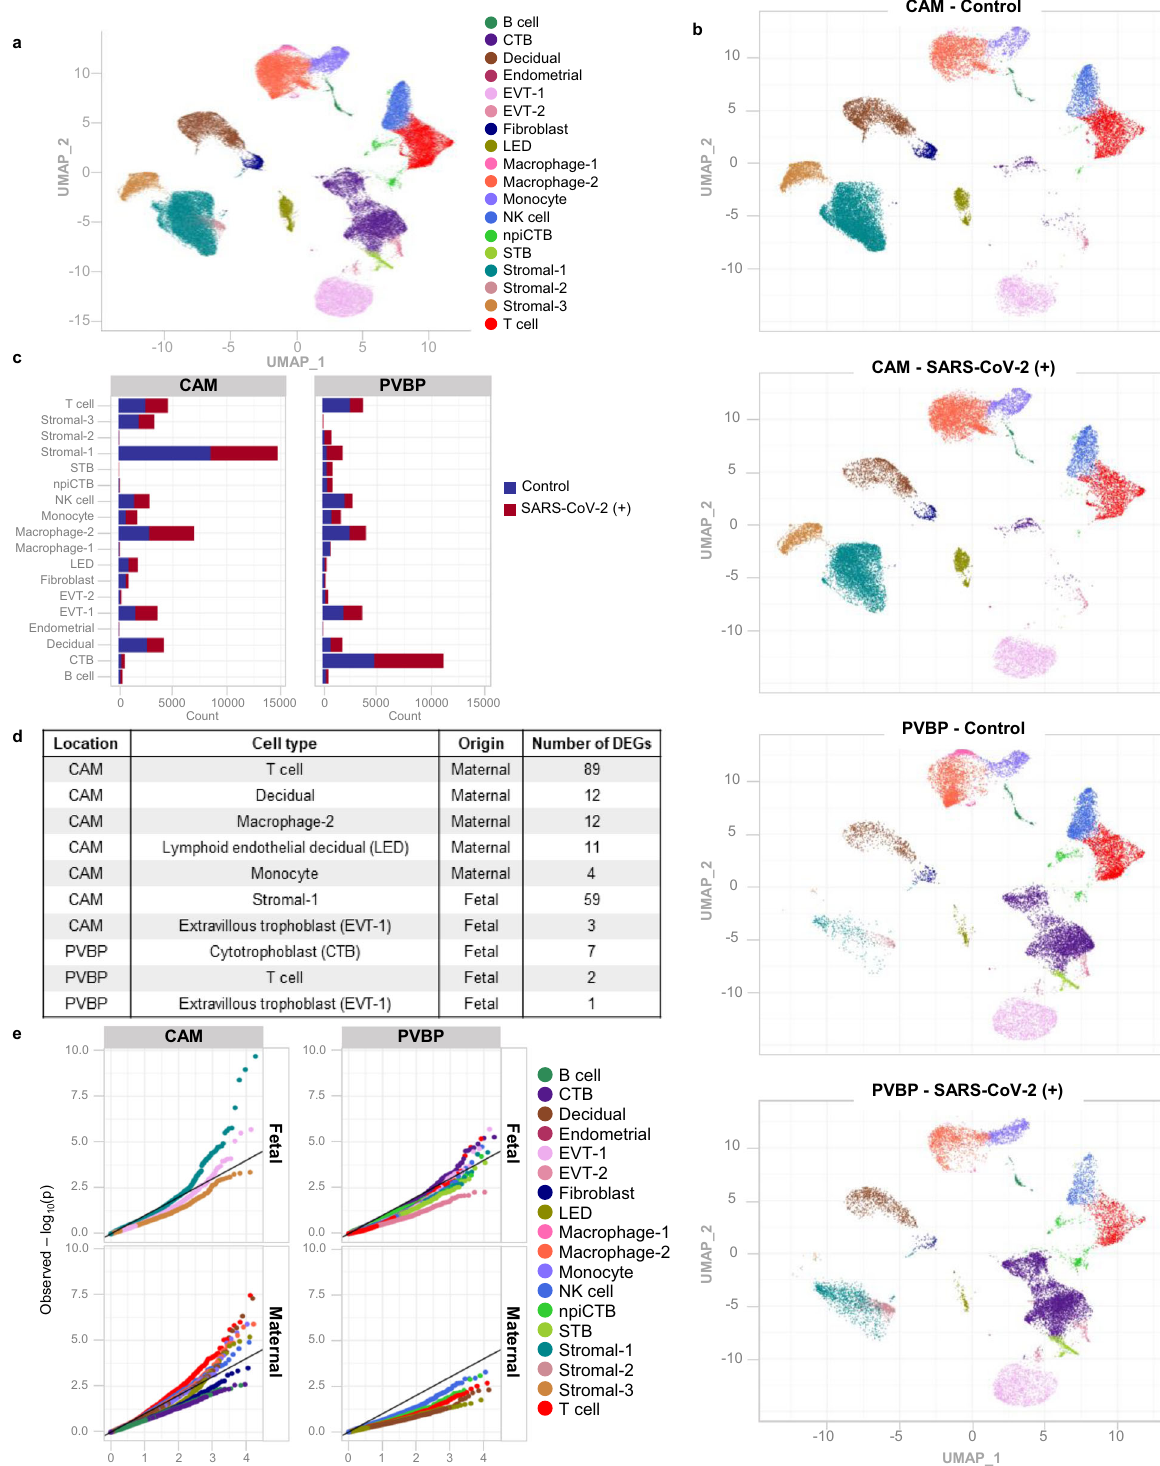
Table 4) and pro fi le. Very few samples (4/15) from cesarean of technical controls, those from vaginal deliveries were distinct, deliveries had a bacterial DNA load exceeding that of technical being dominated by DNA signals from Lactobacillus and Urea- controls for background DNA contamination (i.e., blank DNA plasma , similar to the vaginal swab positive controls (Fig. 8c). extraction kits), yet almost all of the samples (29/30) from vaginal Among the samples obtained from vaginal deliveries, there was deliveries did (Fig. 8b). Furthermore, whereas the bacterial DNA no difference in the bacterial DNA pro fi les based on maternal pro fi les of samples from cesarean deliveries were similar to those SARS-CoV-2 infection status (Fig. 8d). These fi ndings show that, NATURE COMMUNICATIONS| (2022) 13:320